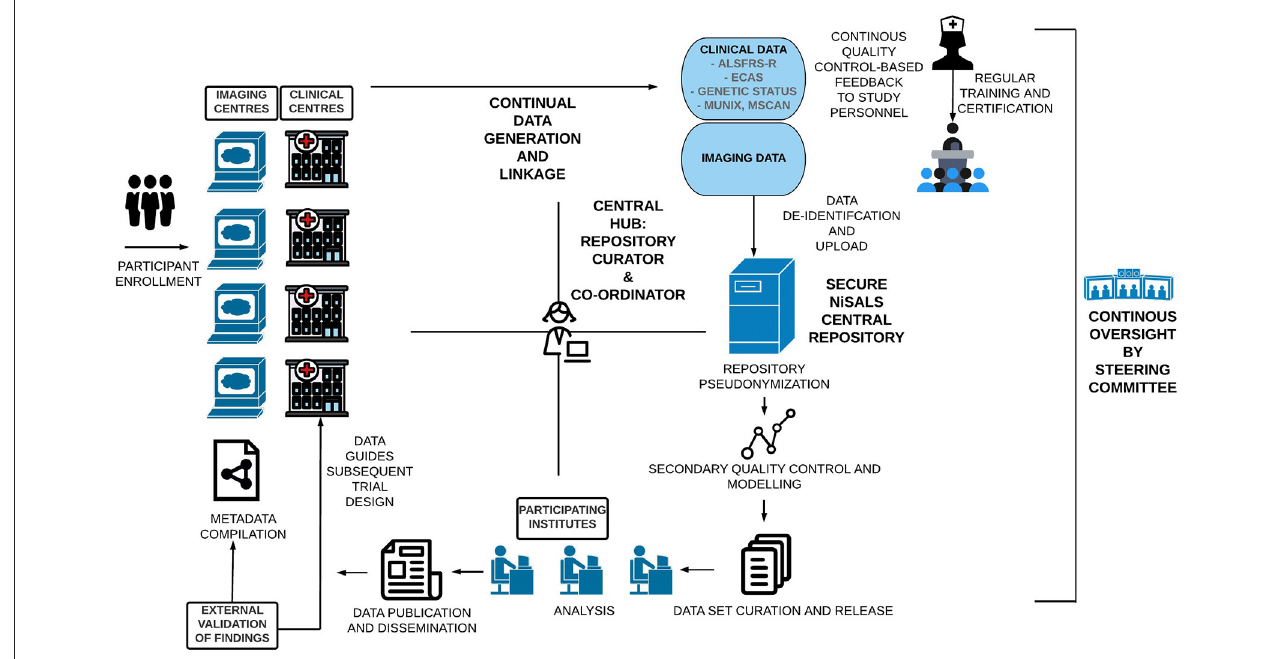
FIGURE 1 | Visual Schematic of the NiSALS ecosystem, including representations of future